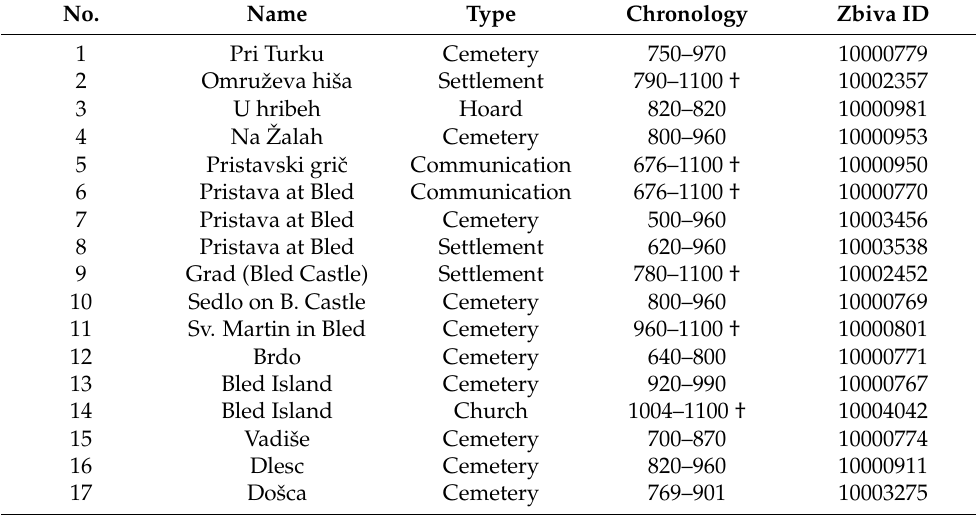
Table 1. Early medieval sites in the Bled microregion; No. refers to Figure 1 (source: